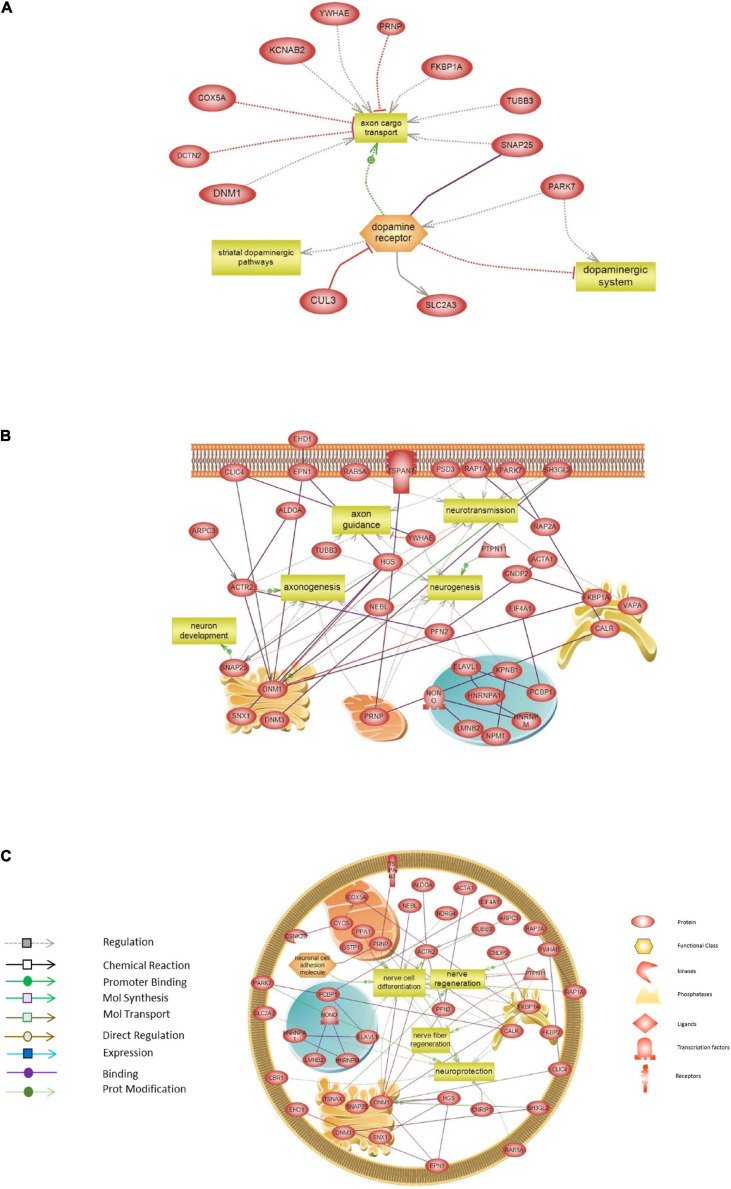
Targeted molecular and biological pathways’ interaction map analysis performed on the genes from the red module. Using Pathway Studio 10.0, altered differential proteins relevant to transplantation in mouse brain were analyzed. Direct interactions algorithm was used to generate and map the targeted network of biological processes and interactions among altered proteins in: (A) The dopaminergic system. (B) Neurogenesis, axonogenesis, neurotransmission, and neuron development. (C) Neuroprotection, nerve cell differentiation, and regeneration. Each of the proteins is displayed within a subcellular compartment or organelle. The shape of each given protein is indicative of its functional class as shown in the legend. Included in the legend is the definition of the lines connecting two proteins.